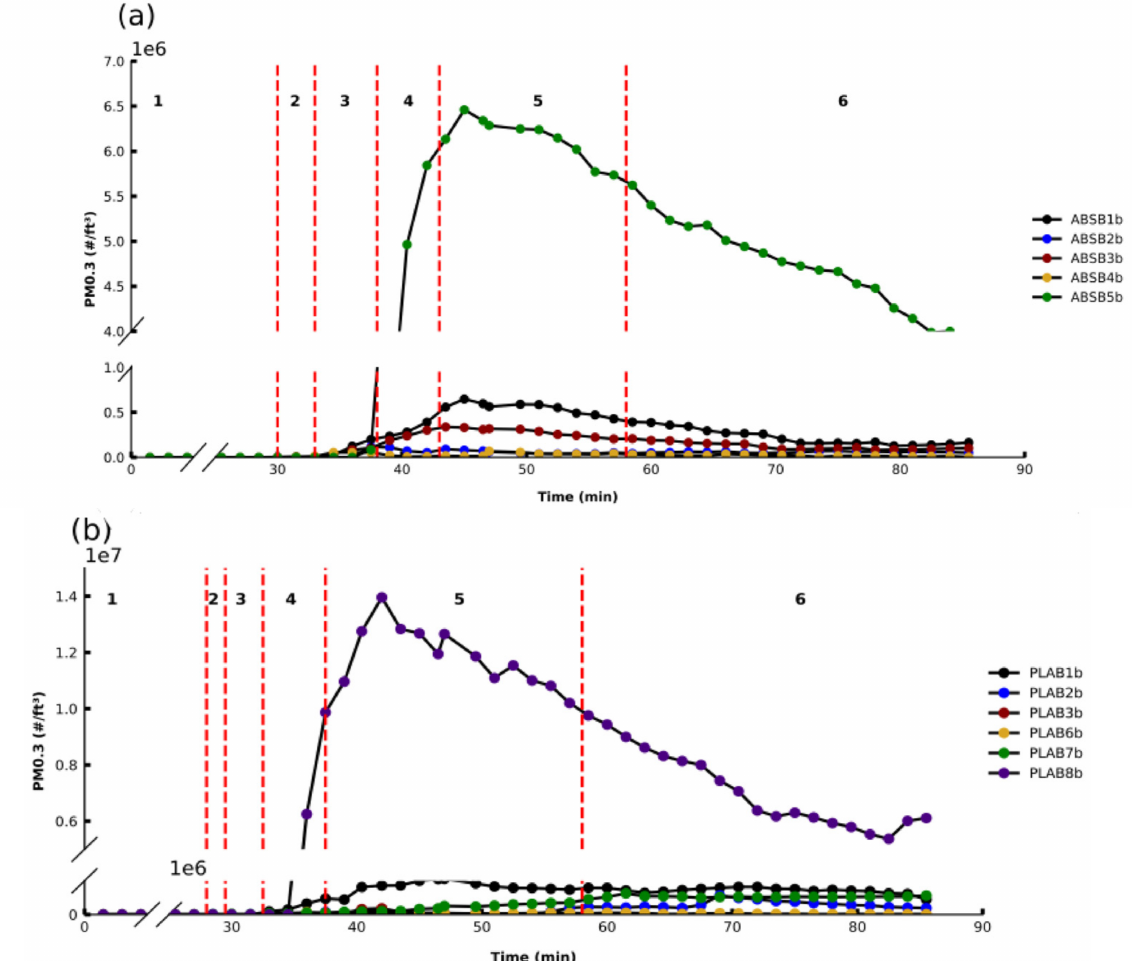
Figure 3. PM 0.3 profiles for different brands over time before, during, and after the printing of a cube for ( a ) ABSB1b, ABSB2b, ABSB3b, ABSB4b, ABSB5b (bedplate temp: 80 ◦ C, extruder temp: 245 ◦ C, 0% fan, 20% infill) and ( b ) PLAB1b, PLAB2b, PLAB3b, PLAB6b, PLAB7b, and PLAB8b (bedplate temp: 50 ◦ C, extruder temp: 205 ◦ C, 20% fan, 20%